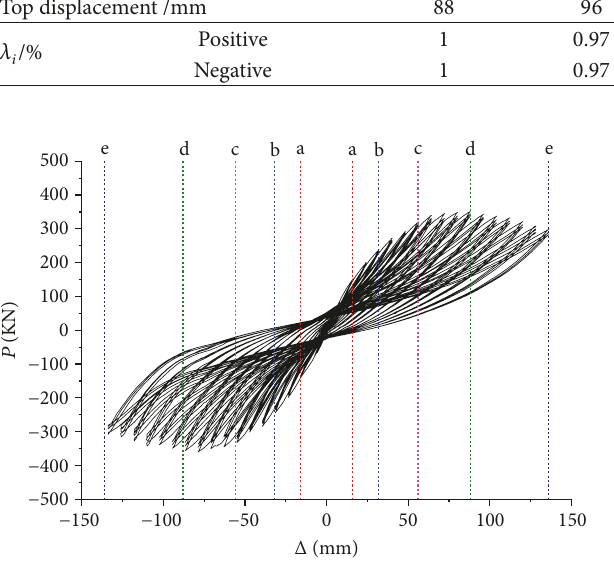
Figure 17: Hysteretic curve.